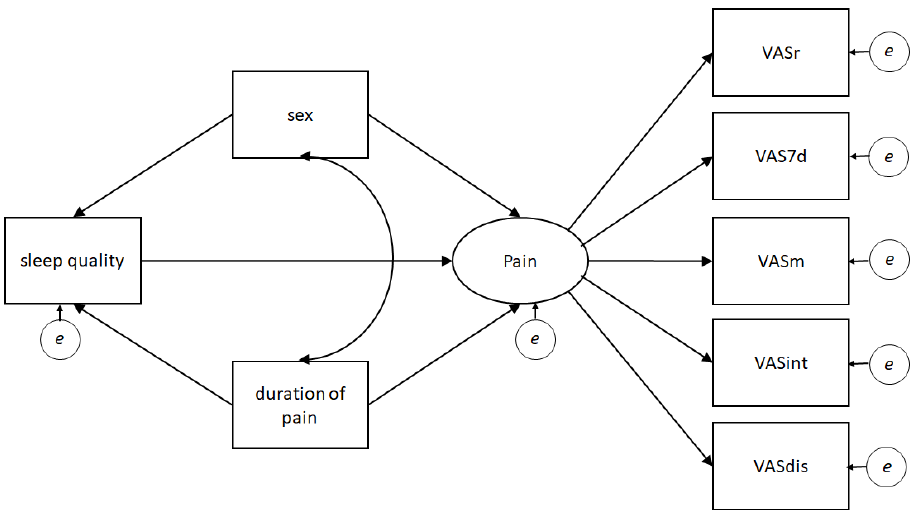
Figure 1. Hypothesized structural equation model. Note: The oval represents the latent variable (i.e., pain), the rectangles the indicators (i.e., measured variables), and the small circles the errors. VAS, visual analog scale; VASr, VAS at rest; VAS7d, average VAS 7 days; VASm, VAS at movement; VASint, VAS pain interference; VASdis, VAS distress relative to pain.